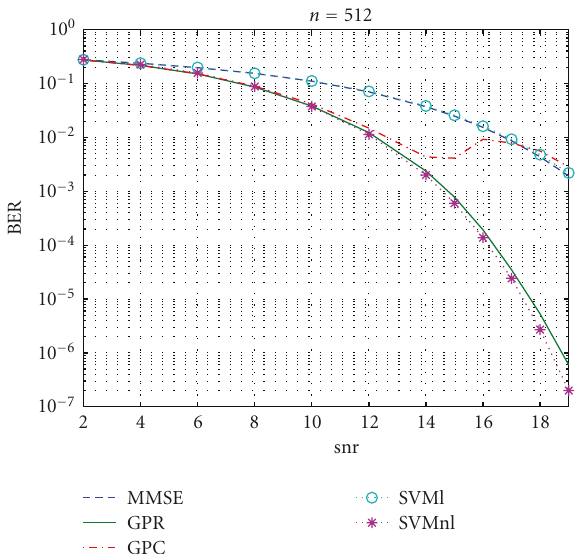
Figure 4: We report the BER versus snr for a channel equalization problem with a nonlinear channel model. The dashed line repre- sents the linear MMSE receiver, the solid line the GPR, the dash- dotted line the GPC, the dotted line with circles the linear SVM, and the dotted line with bullets the nonlinear